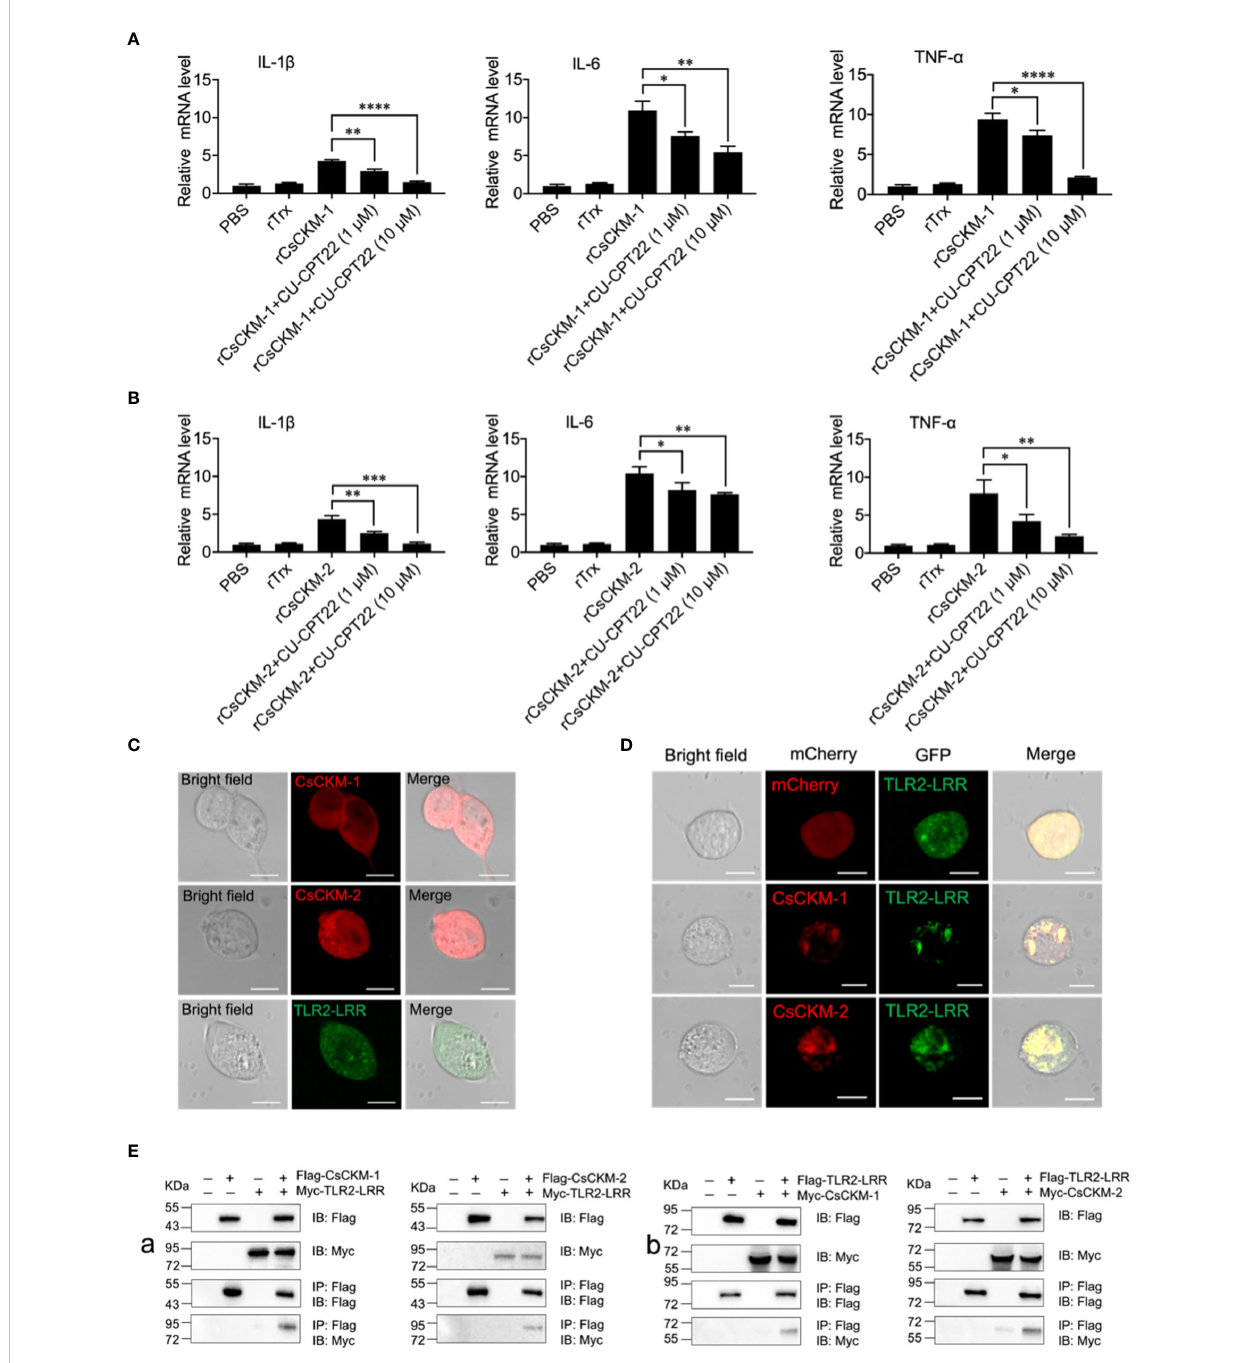
FIGURE 5 The involvement of TLR2 in CsCKM-1/2-induced immune response. (A) Tongue sole PBLs were incubated with PBS, rTrX, rCsCKM-1, or rCsCKM-1 plus different concentrations of CU-CPT22 for 2 h. The expression of IL-1 b , IL-6 and TNF- a was determined by qRT-PCR. (B) PBLs were incubated with PBS, rTrX, rCsCKM-2, or rCsCKM-2 plus different concentrations of CU-CPT22 for 2 h. Gene expression was determined as above. For both (A, B) , values are the means of triplicate assays and shown as means ± SD. *P < 0.05; **P < 0.01; ***P < 0.001, ****P < 0.0001. (C) HEK293T cells were transfected with mCherry-tagged CsCKM-1/2 or GFP-tagged TLR2-LRR and observed with a confocal microscope. (D) HEK293T cells co- expressed GFP-tagged TLR2-LRR and the mCherry tag, or co-expressed TLR2-LRR and mCherry-tagged CsCKM-1/2. Protein colocalization was observed with a confocal microscope. Scale bar, 10 m m. (E) Flag-tagged CsCKM-1/2 and Myc-tagged TLR2-LRR (Ea), or Myc-tagged CsCKM-1/2 and Flag-tagged TLR2-LRR (Eb) were co-expressed in HEK293T cells for 24 h. Co-immunoprecipitation and immunoblotting were performed with antibodies against Myc-tag and